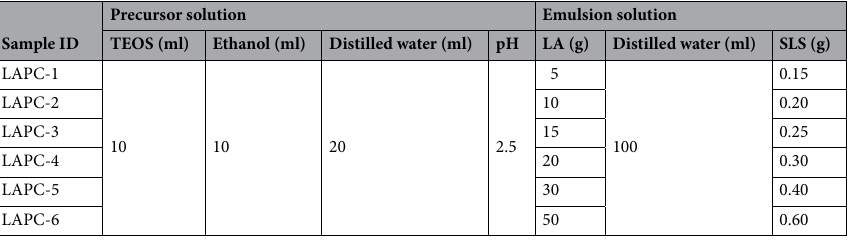
Table 1. Details composition for microencapsulation of